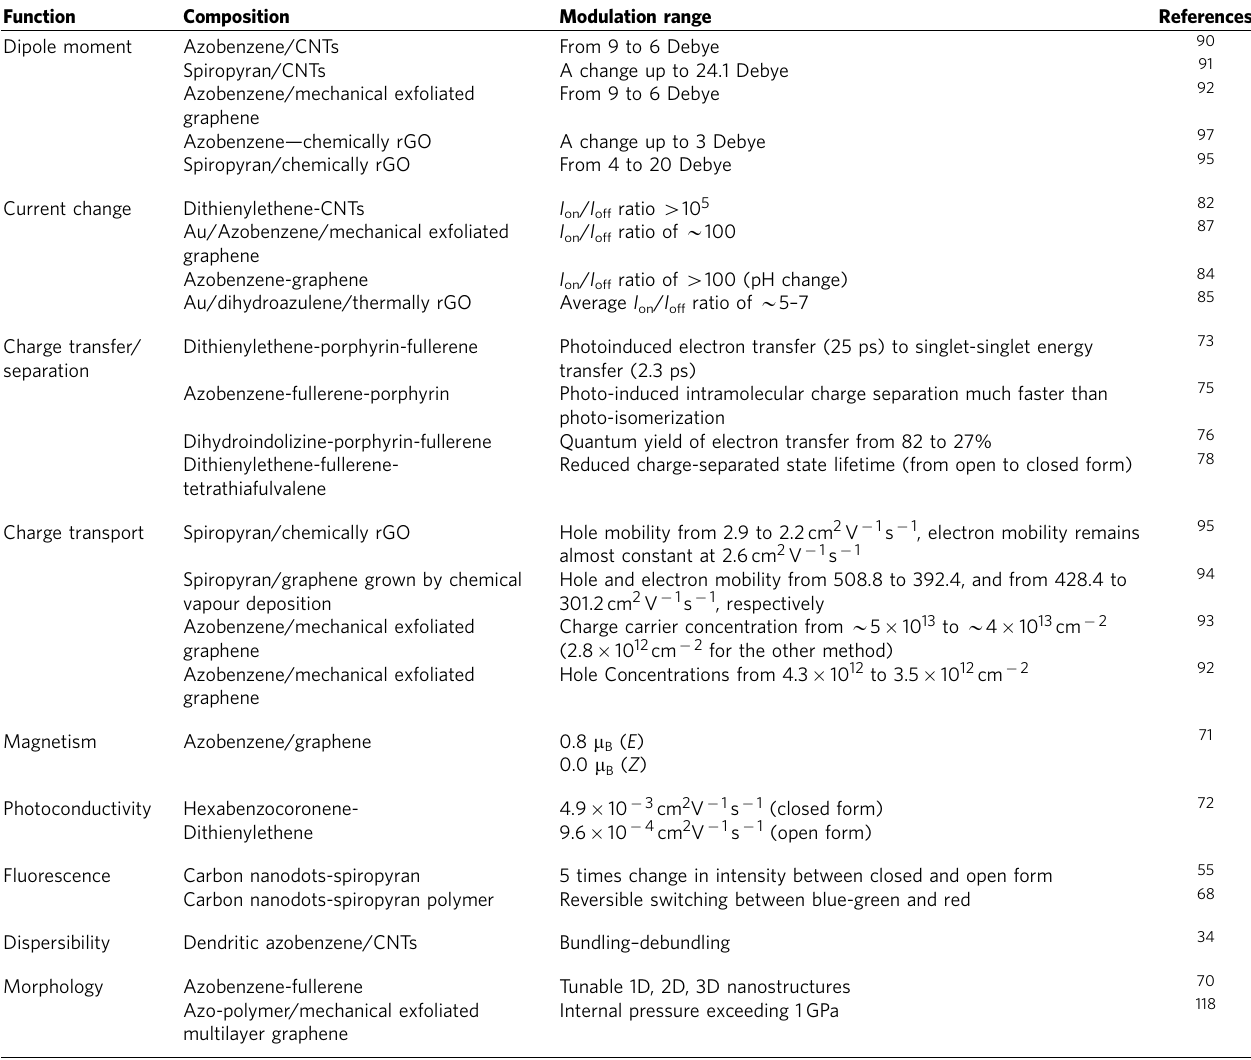
Table 2 | Modulated properties of photochromic carbon-based